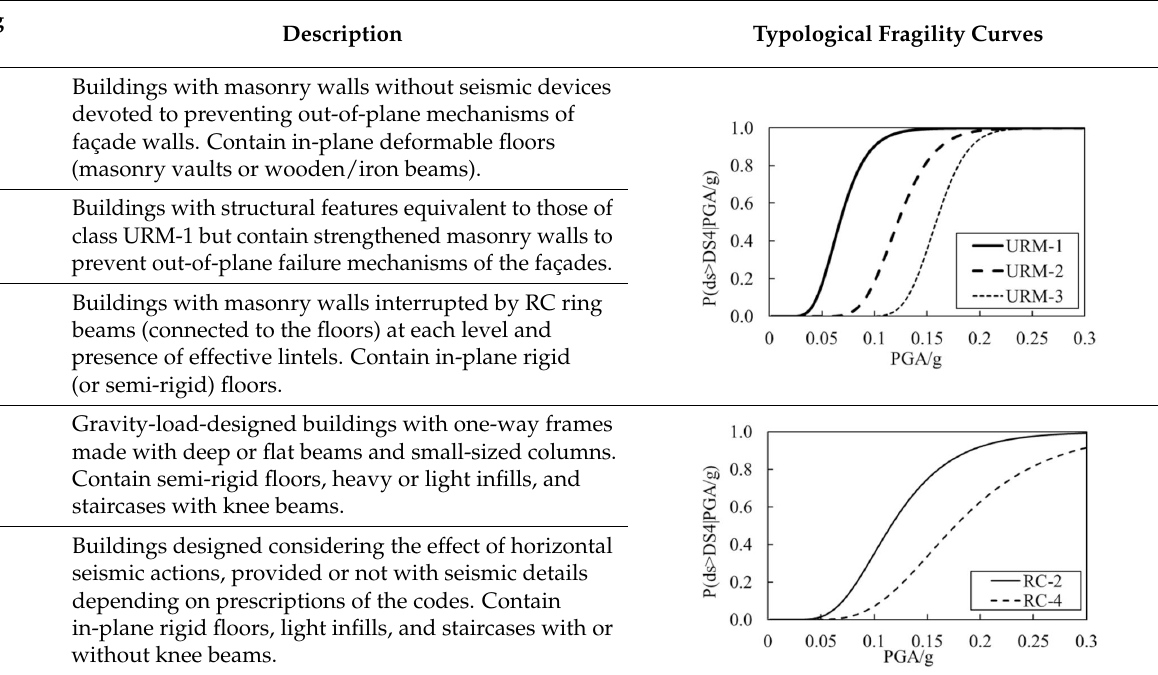
Table 3. Description of building classes used in this paper and typological fragility curves